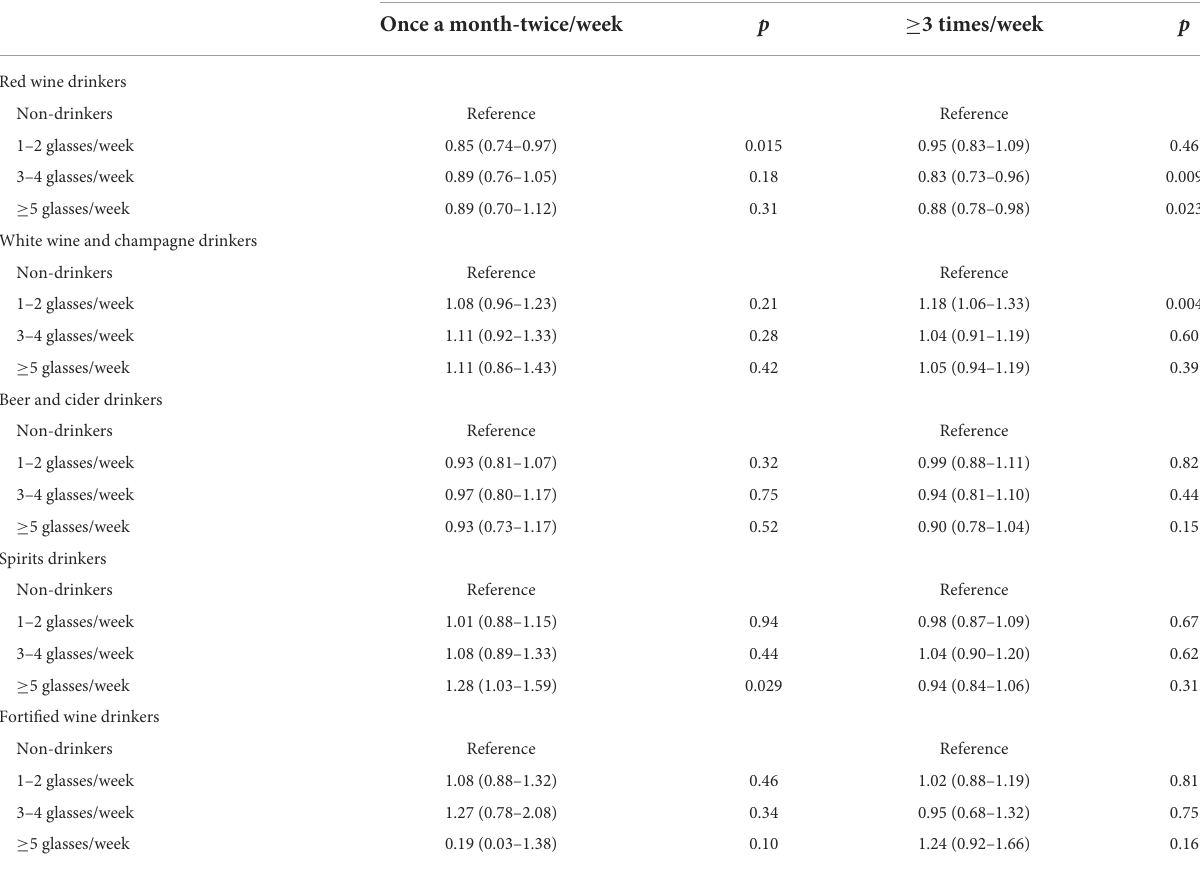
TABLE 4 Odds ratios and 95% CIs for the association between different alcoholic beverages and IBD risk, separated by frequency of alcohol